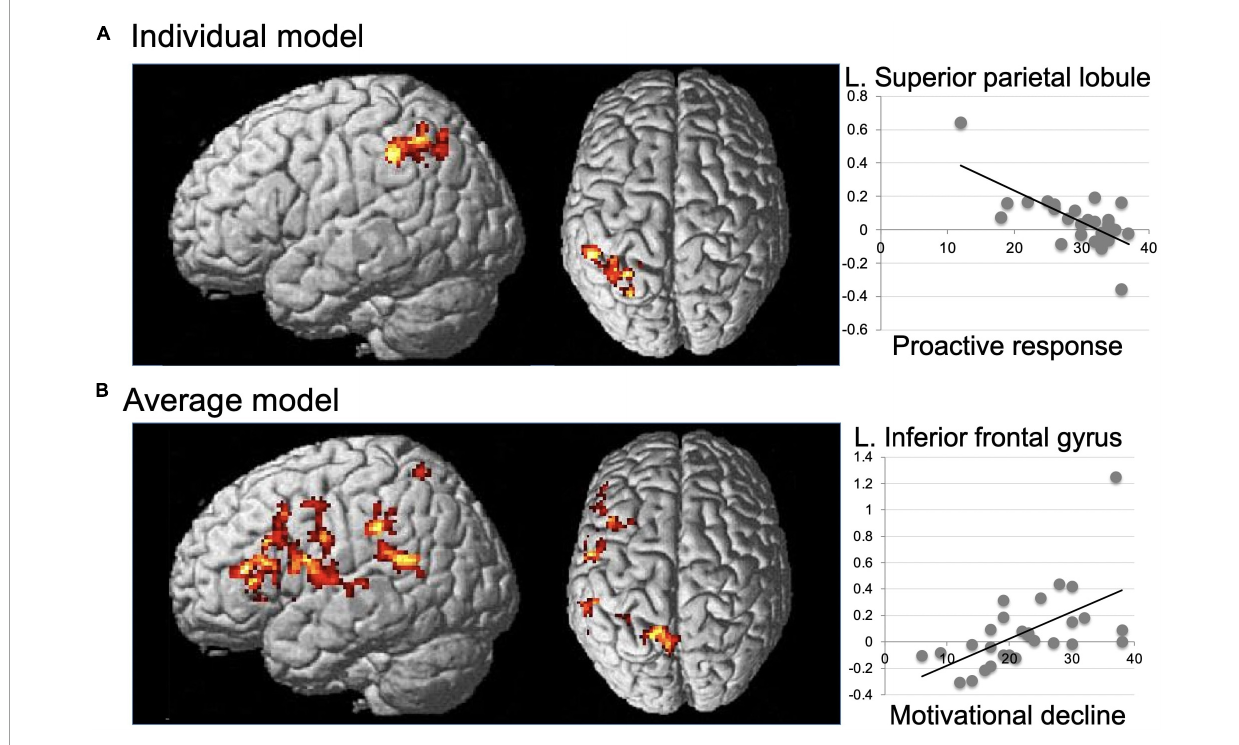
FIGURE3 Significant effects of the MTASQ score on discomfort-related activation (second approach). Left panels, significant negative effect of the proactive response on individual-model-derived discomfort-related activation (A) and significant positive effect of motivational decline on average-model-derived activation (B) are superimposed on the standard anatomical brain. Other details are the same as for Figure 2